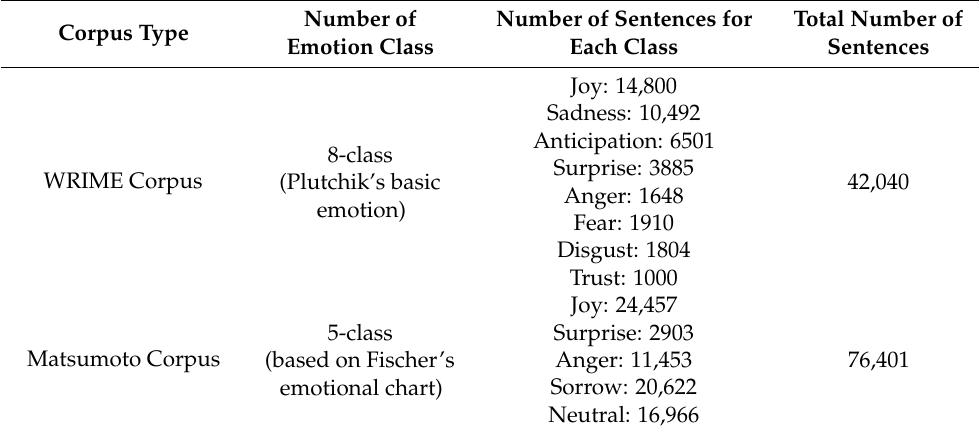
Table 1. Breakdown of the emotional